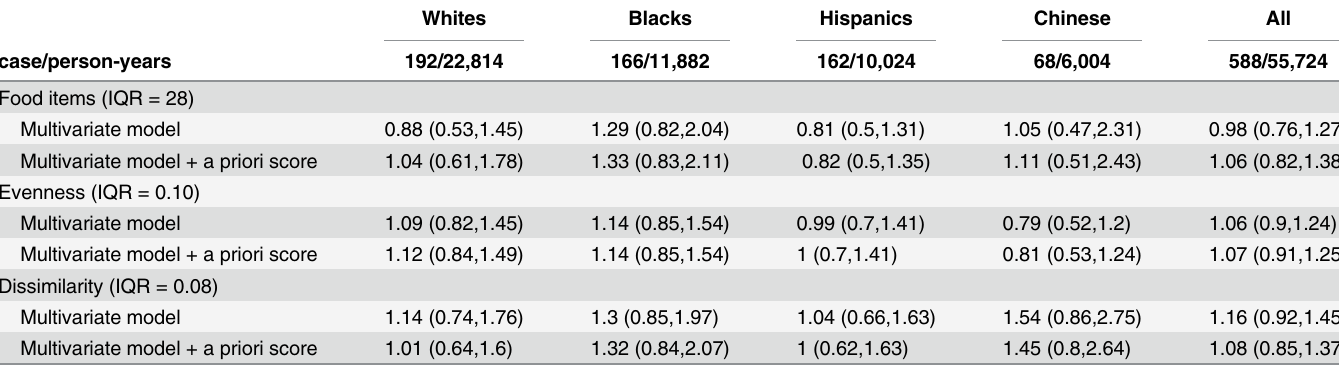
Table 3. HRs (95% CIs) of type II diabetes for 1-interquintile range (IQR) unit of dietary diversity metrics in 5,160 U.S. adults. Whites Blacks